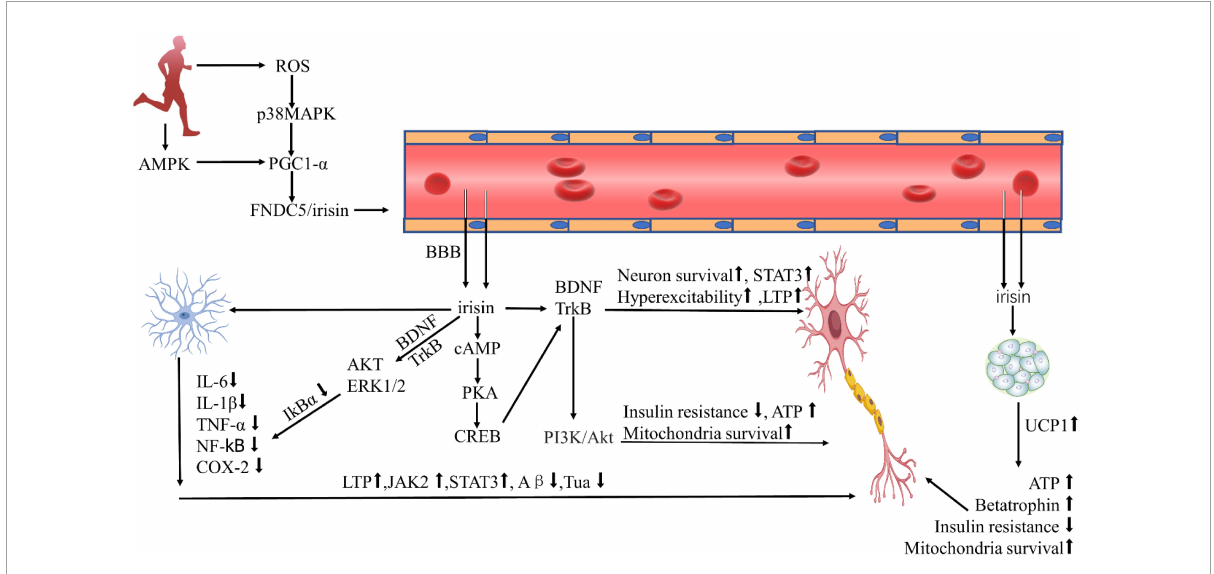
FIGURE1 Protective effect of irisin against Alzheimer’s disease. ROS, reactive oxygen species; AMPK, AMP-activated protein kinase; PGC-1 α , PPAR γ coactivator 1 α ; FNDC5, fibronectin type III domain-containing protein-5; BDNF, brain-derived neurotrophic factor; cAMP, cyclic adenosine monophosphate; PKA, protein kinase A; CREB, cAMP-response element binding protein; P13K, phosphatidylinositol 3 kinase; Akt, protein kinase B; ERK1/2, extracellular signal-regulated kinase1/2; IL-6, interleukin-6; IL-1 β , interleukin-1 β ; TNF- α , tumor necrosis factor- α ; NF- κ b, nuclear factor κ b; COX-2, cyclooxygenase-2; LTP, long-term potentiation; STAT3, signal transducer and activator of transcription-3; UCP1, uncoupling protein-1; BBB, blood-brain barrier; ATP, adenosine triphosphate.